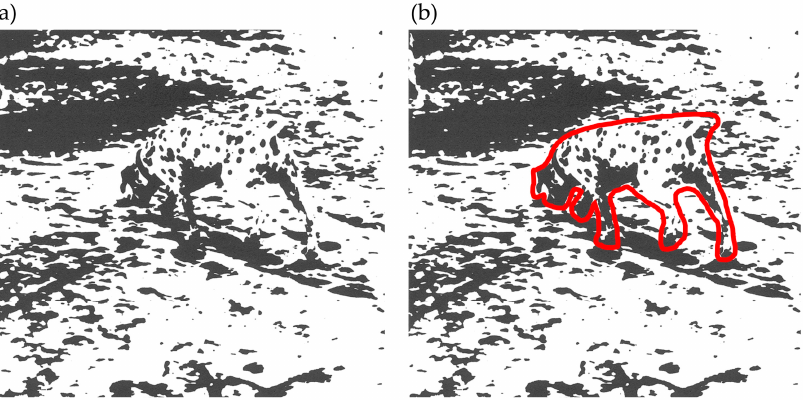
Figure 3. Hidden figure. ( a ) An apparently random collection of black shapes on a white background. ( b ) When a portion of the black shapes are outlined, it becomes evident that there is a Dalmatian dog sniffing the ground in the image. (Images based on [67]).